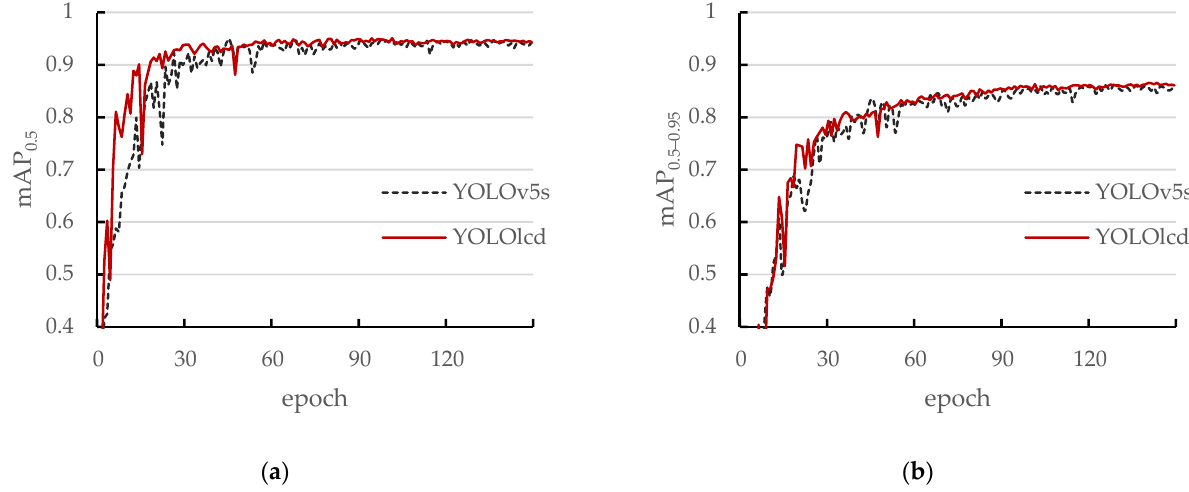
Figure 6. Changes in the mAP of YOLOsx and YOLOsxlc on validation set during training: ( a ) changes in mAP 0.5 on validation set; ( b ) changes in mAP 0.5–0.95 on validation set.